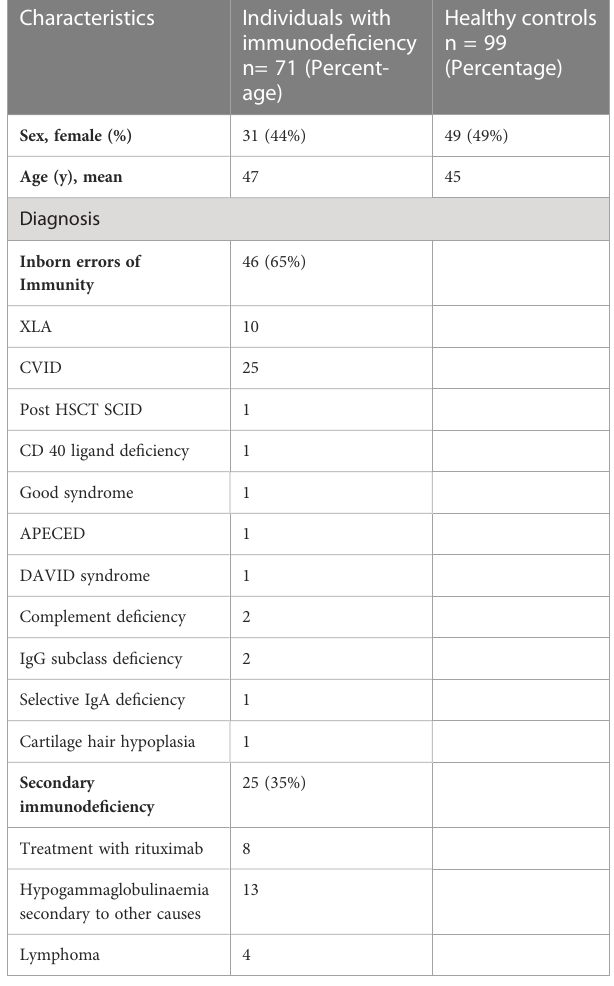
TABLE 3 Common co-morbidities of the individuals with secondary immunode fi